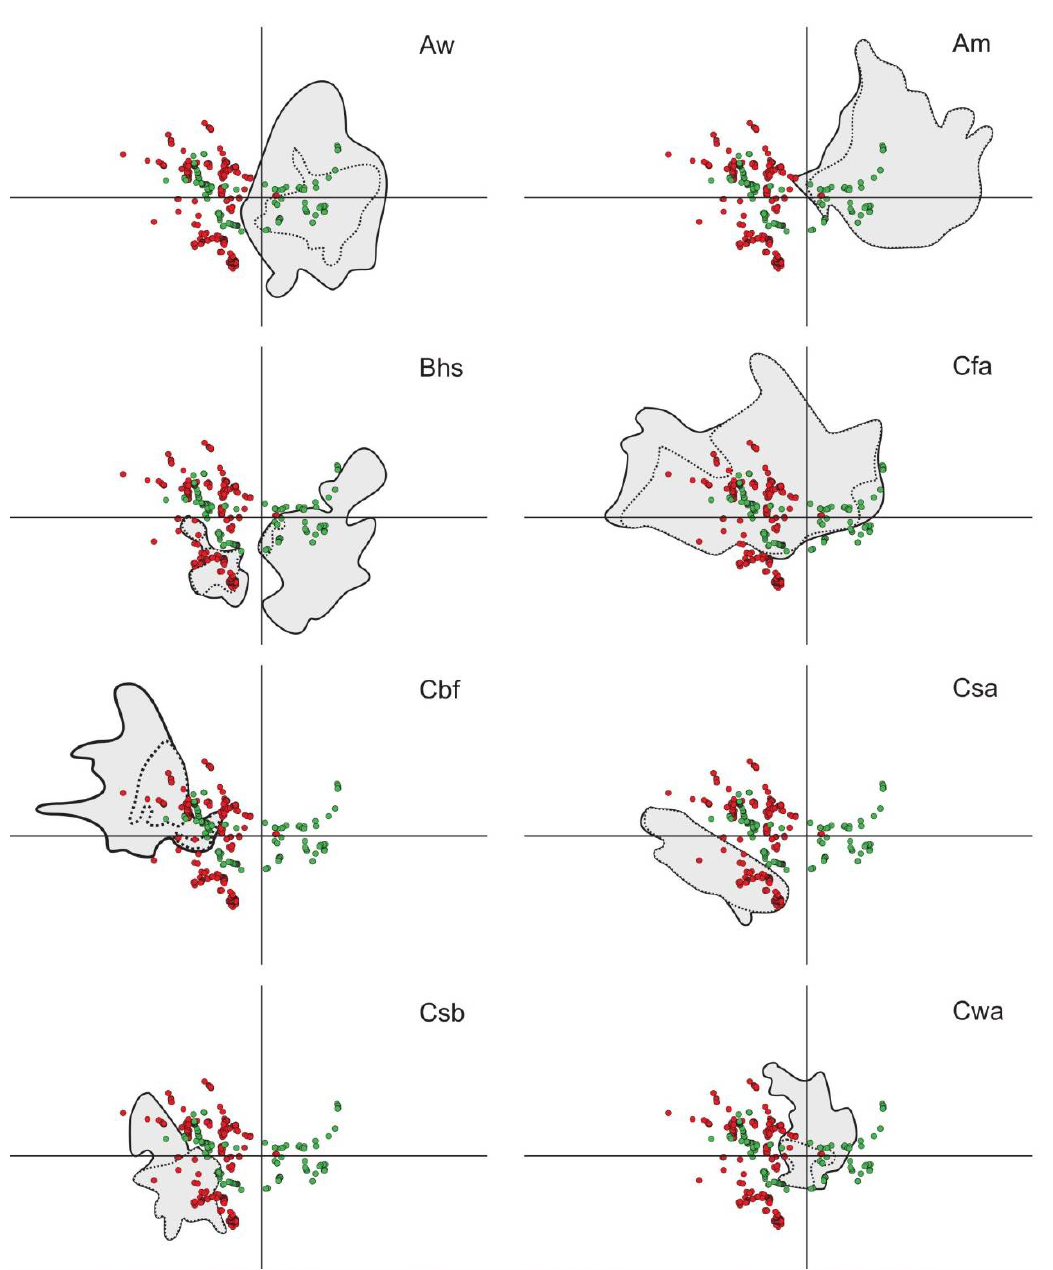
Figure 5. PCA biplots that represent the partial environmental space that indicates the climatic profile of the species O. drummondii in each Köppen–Geiger climatic region. Dots represent the presence records of: (i) all native populations (green) and (ii) all non-native populations (red). Clouds represent the environmental space for each climatic region; in these, the solid line represents the fraction of the fundamental niche and the dotted line the fraction of the realized niche within each Köppen–Geiger climatic region.